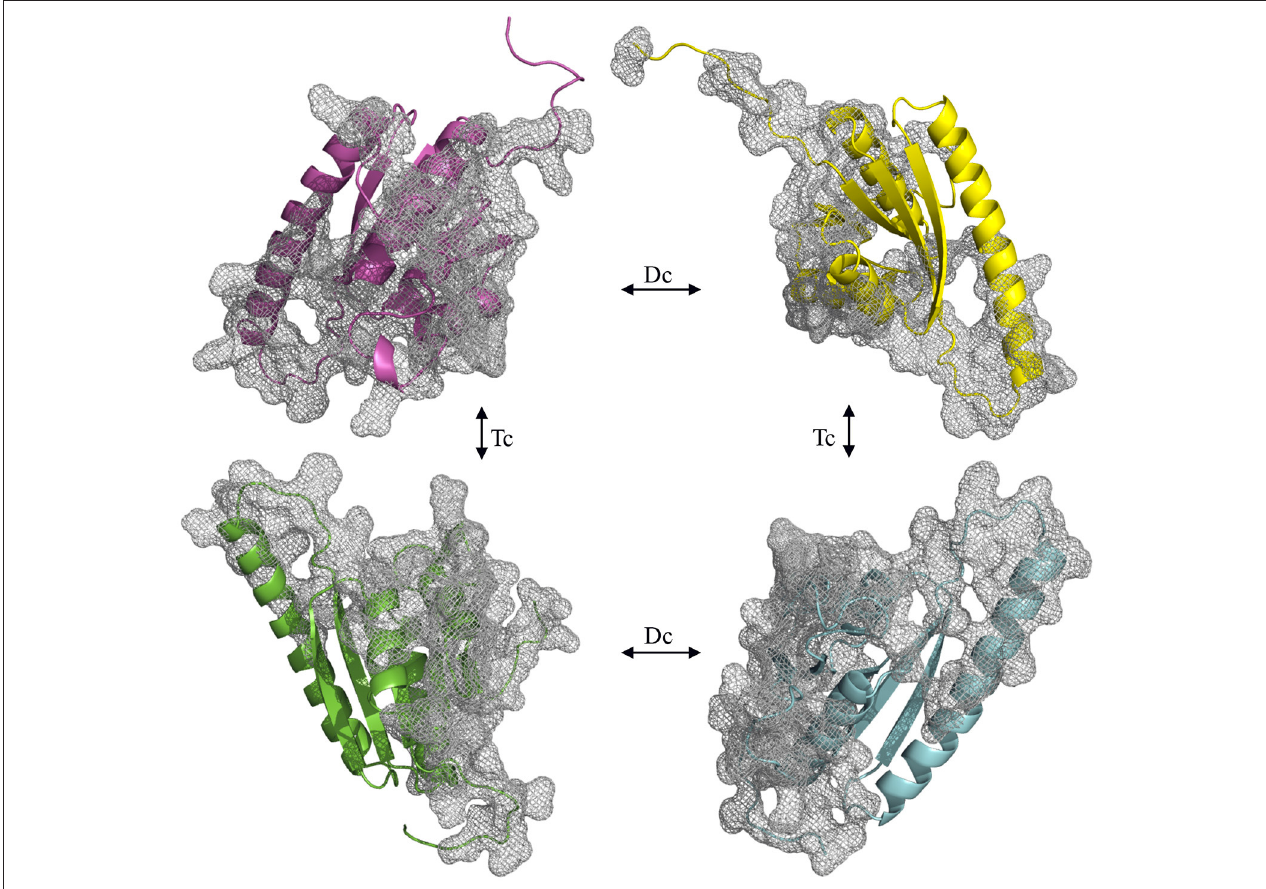
FIGURE 7 | Opened view of the Model_USP-691. The grid represents the interfaces involved into dimeric (Dc) and tetrameric (Tc) contact. The chains are represented in green (chain_A), cyan (chain_B), magenta (chain_C), and yellow